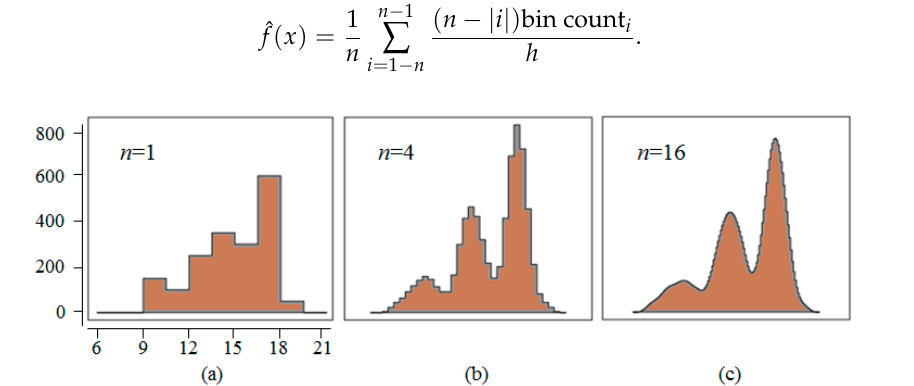
Figure 2. A simple example of the ASH method for the step count in one day: ( a ) a histogram, ( b ) an ASH estimate of 4 shifted histograms, and ( c ) an ASH estimate of 16 shifted histograms.